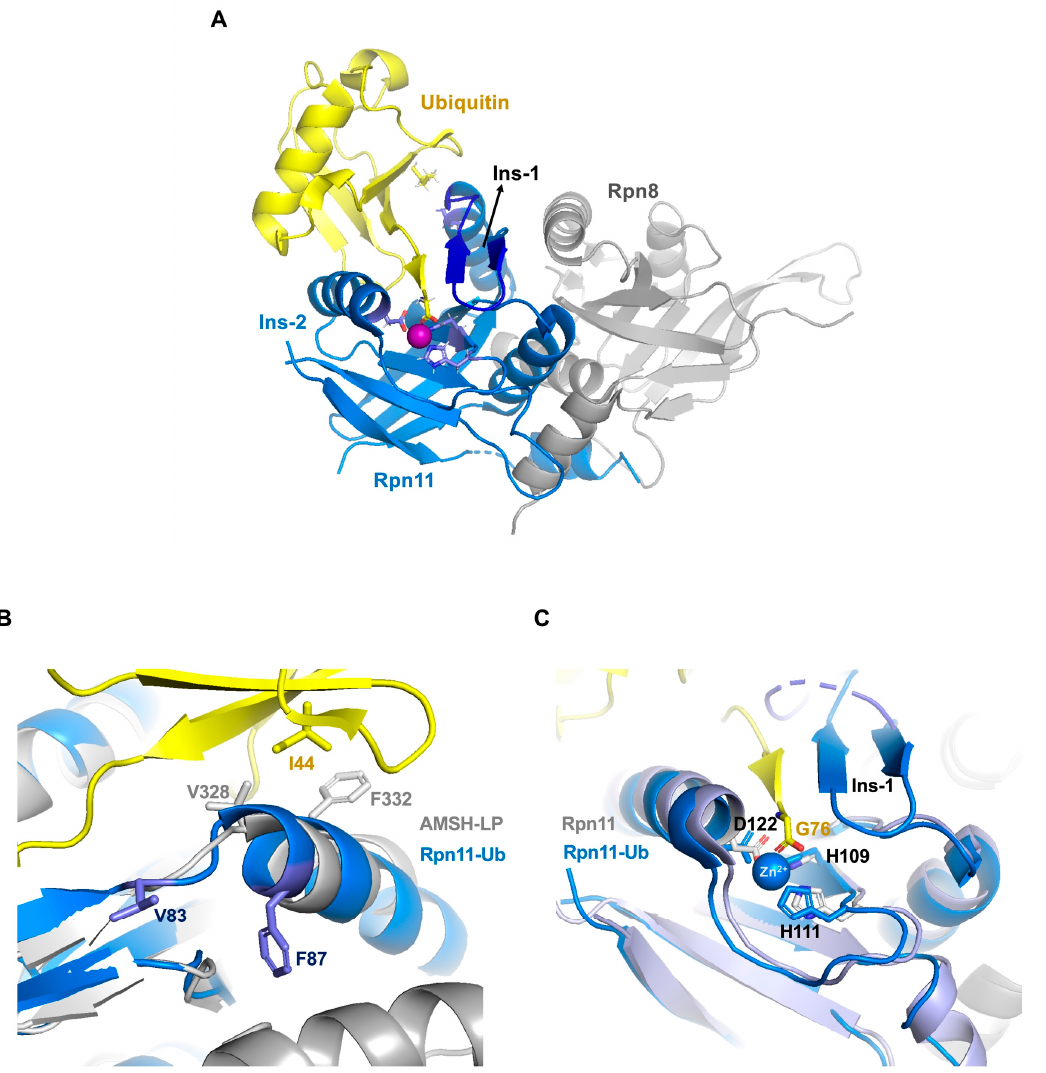
Figure 6. Structure of Ubiquitin-Bound Rpn11-Rpn8. ( A ) Structure of Rpn11-Rpn8 with ubiquitin. Ubiquitin (yellow), Rpn11 (blue), Rpn8 (gray), Zinc (purple) ( B ) Comparison of conserved binding sites of Rpn11 and AMSH-LP for the Ile44-ubiquitin-binding surface. Rpn11 (blue), AMSH-LP (gray). Val83 and Phe87 are from Rpn11, Val328 and Phe332 are from AMSH-LP. ( C ) Comparison of the active sites of Rpn11 and Rpn11-Ub. (PDB: 5U4P, 5W83, 4O8X and 2ZNV).